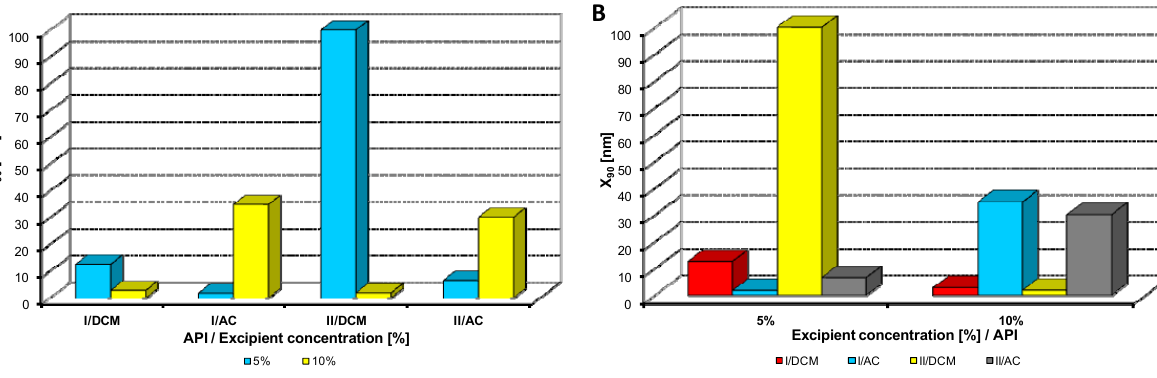
[nm]) of model APIs I , II on concentration [%] Figure 6. Dependence of particle size (x 90 of sodium carboxymethyl dextran in dichloromethane (DCM) or acetone (AC). ( A ) Samples are grouped according to APIs; ( B ) samples are grouped according to excipient percentage. For clarity sake, the values on y-axis are only to 100